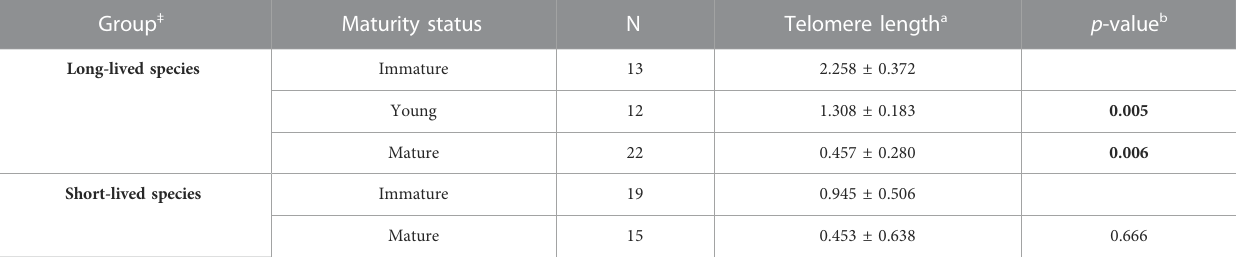
TABLE 3 Relative telomere length at different maturity status of the different longevity ‡ Groups at standardized age. Group ‡